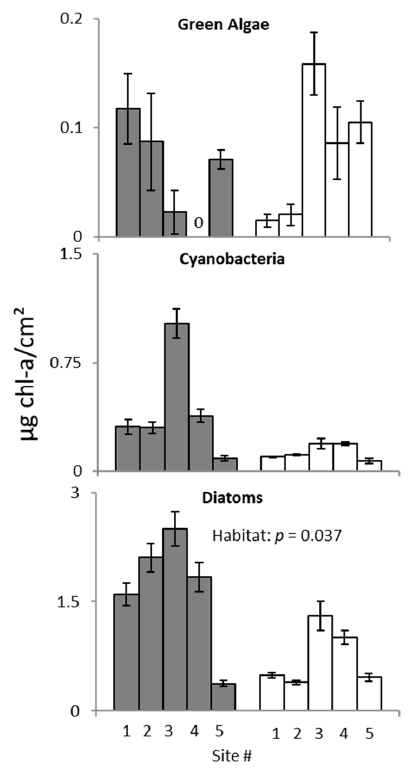
Figure 5. Benthic algal biomass across saltmarsh (dark grey) and mangrove (white) sites along the ecotone. Significant results are displayed in the inset panel. Data are shown as the mean ± SEM for five replicate